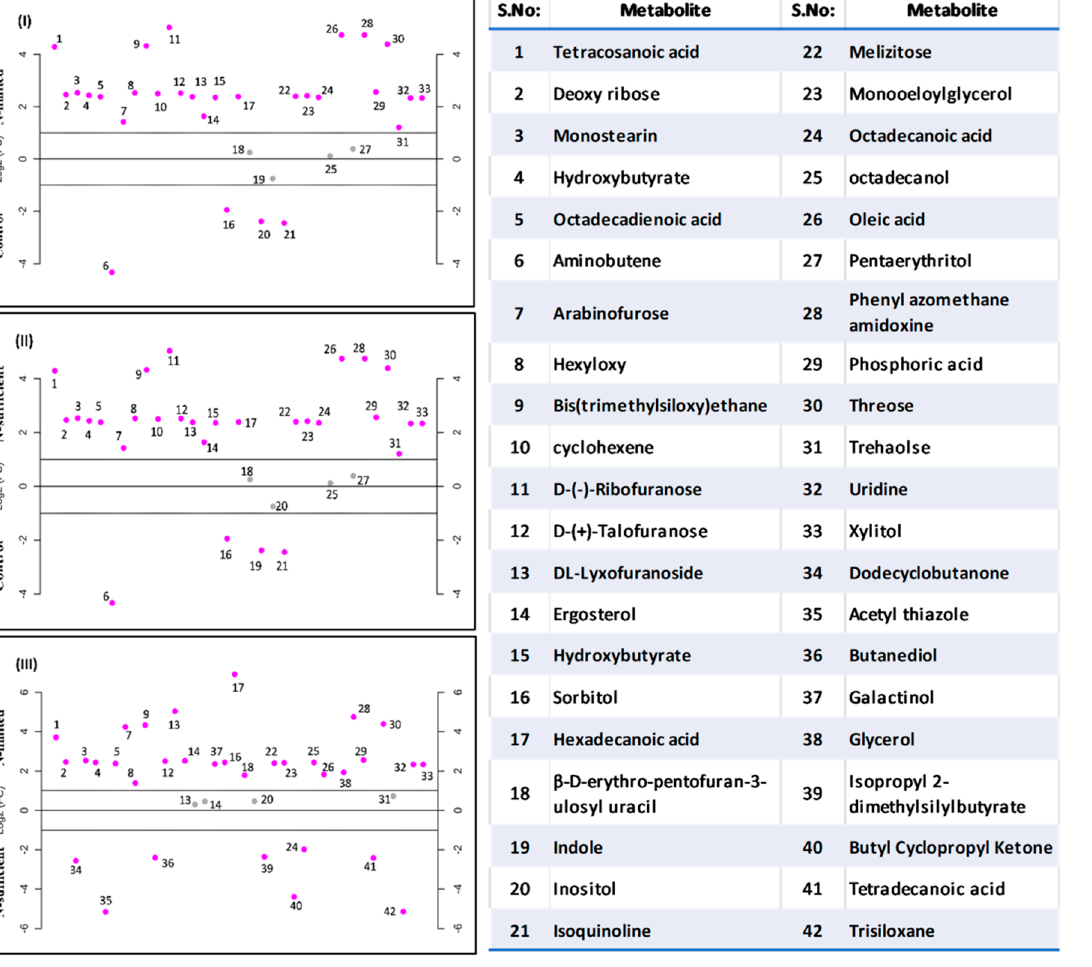
Figure 6. Dot-plot representing upregulated and downregulated intracellular metabolites of ( I ) N-limited with control; ( II ) N-sufficient with control; ( III ) N-limited with N-sufficient at 192 h of cultivation (grey dots denote the metabolites that show < log 2-fold change and pink dots denote the metabolites that show > log 2-fold change) in R. toruloides. The table represents numerical abbreviations of the metabolites. All 42 data points does not appear in all the panels as some metabolites were detected in nitrogen limiting condition which were not present in nitrogen sufficient condition or in control.